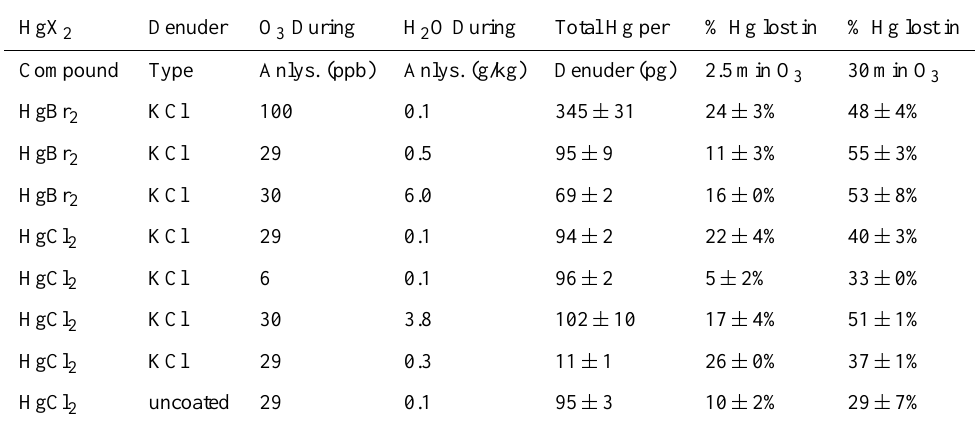
Table 1. Results of experiments in which denuders were loaded with HgX 2 , then analyzed via 30min ozone followed by 30min heating at 500 ◦ C with no ozone. The right-most columns show mean ± standard deviation for two replicate denuders. Experimental design 1: ozonation after loading with HgX 2 in Lab